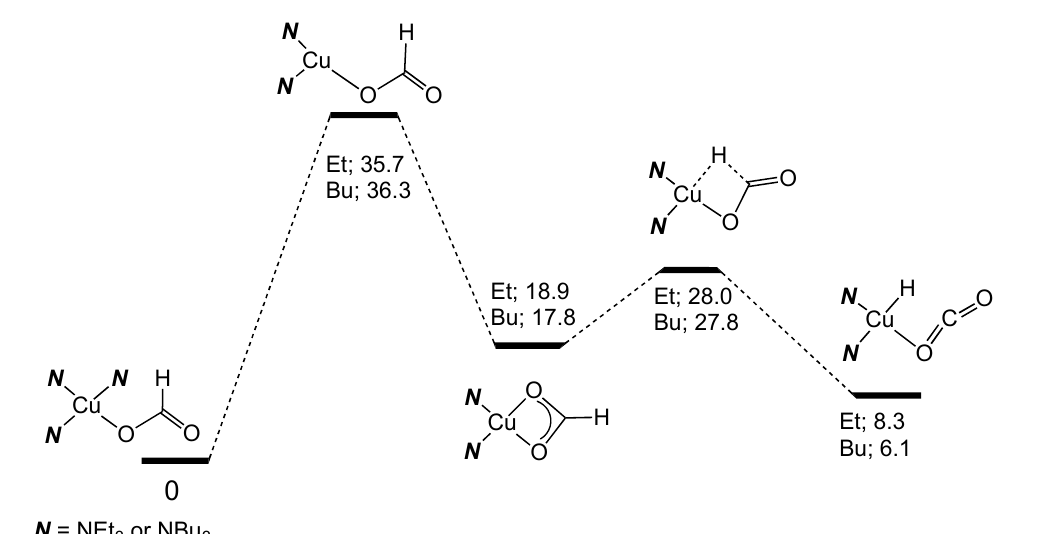
Scheme 14. Energy profile for the beta β -hydrogen elimination process to give a cis -[CuH(NR 3 ) 2 ( κ 1 - O -CO 2 )] intermediate. The substitution of CO 2 by one molecule of NR 3 from cis -[CuH(NR 3 ) 2 ( κ 1 - O -CO 2